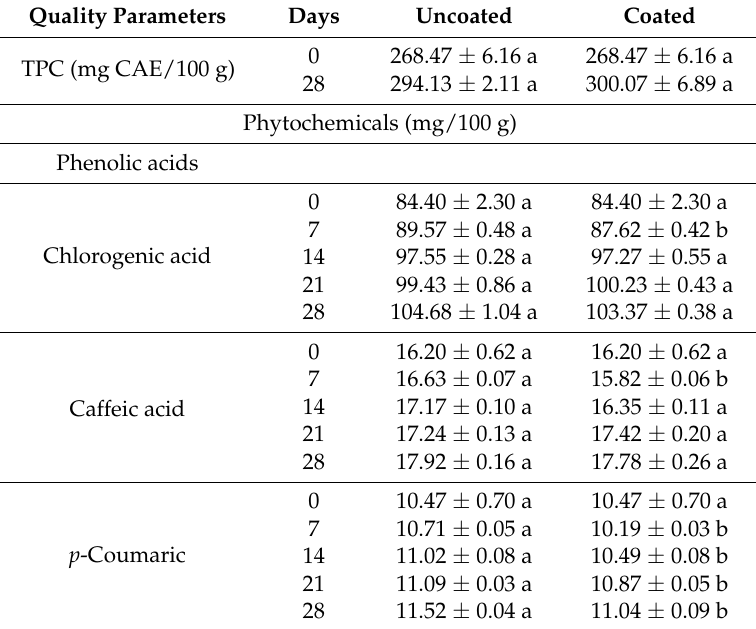
Table 3. Contents of total phenolics and phenolic acids in uncoated and coated blueberries fruit. Fruit were stored at 4 ◦ C for up to 28 days.